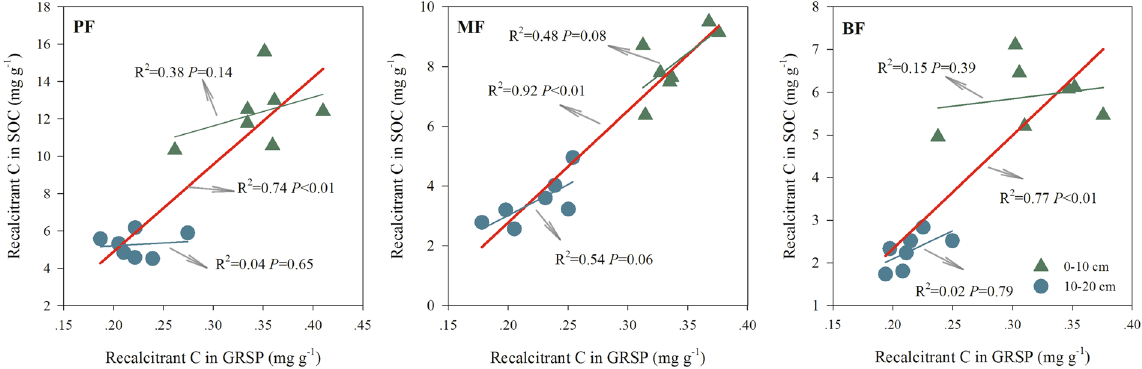
Figure 4. The relationship between the recalcitrant C concentrations (mg g − 1 ) in the SOC and GRSP in the tropical forests of DBR, southern China.